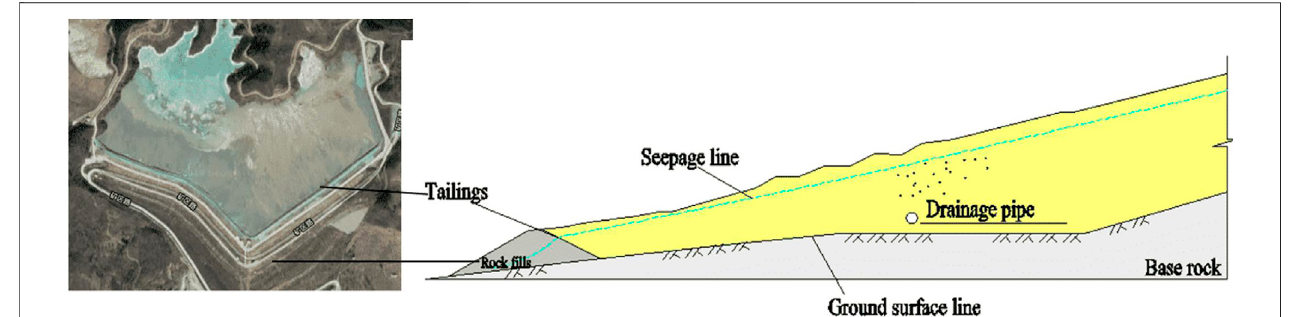
FIGURE 7 | Topographic map of the Earth ’ s surface and tailings